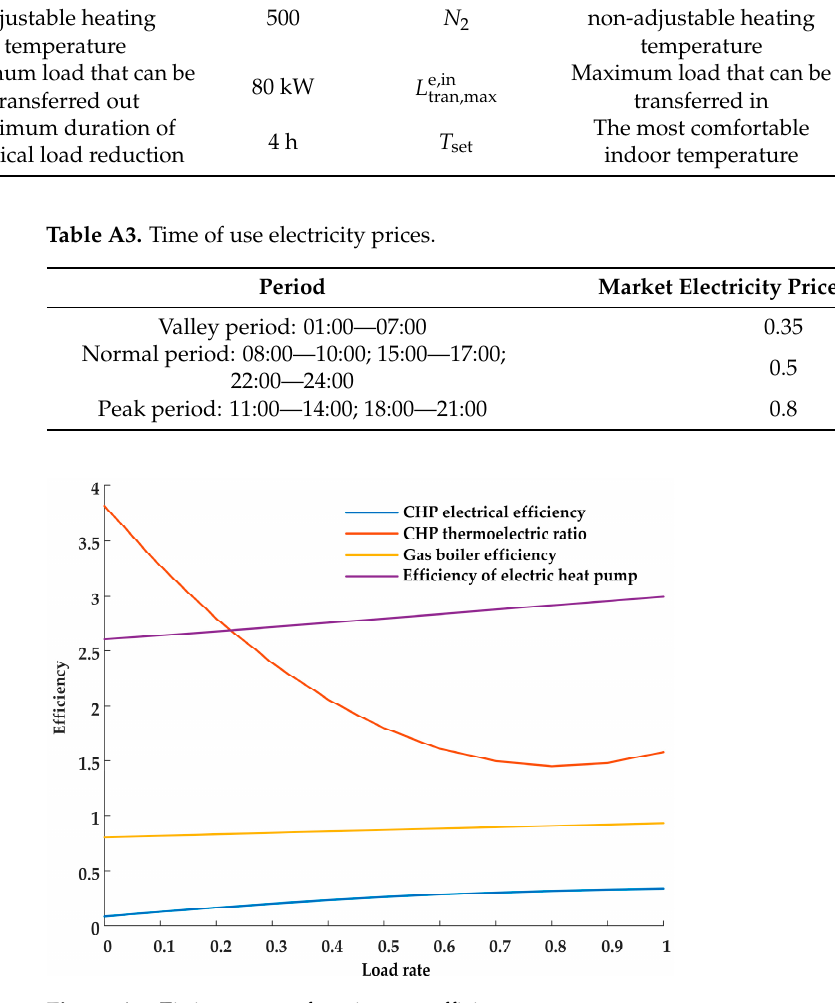
Figure A1. Fitting curve of equipment efficiency.